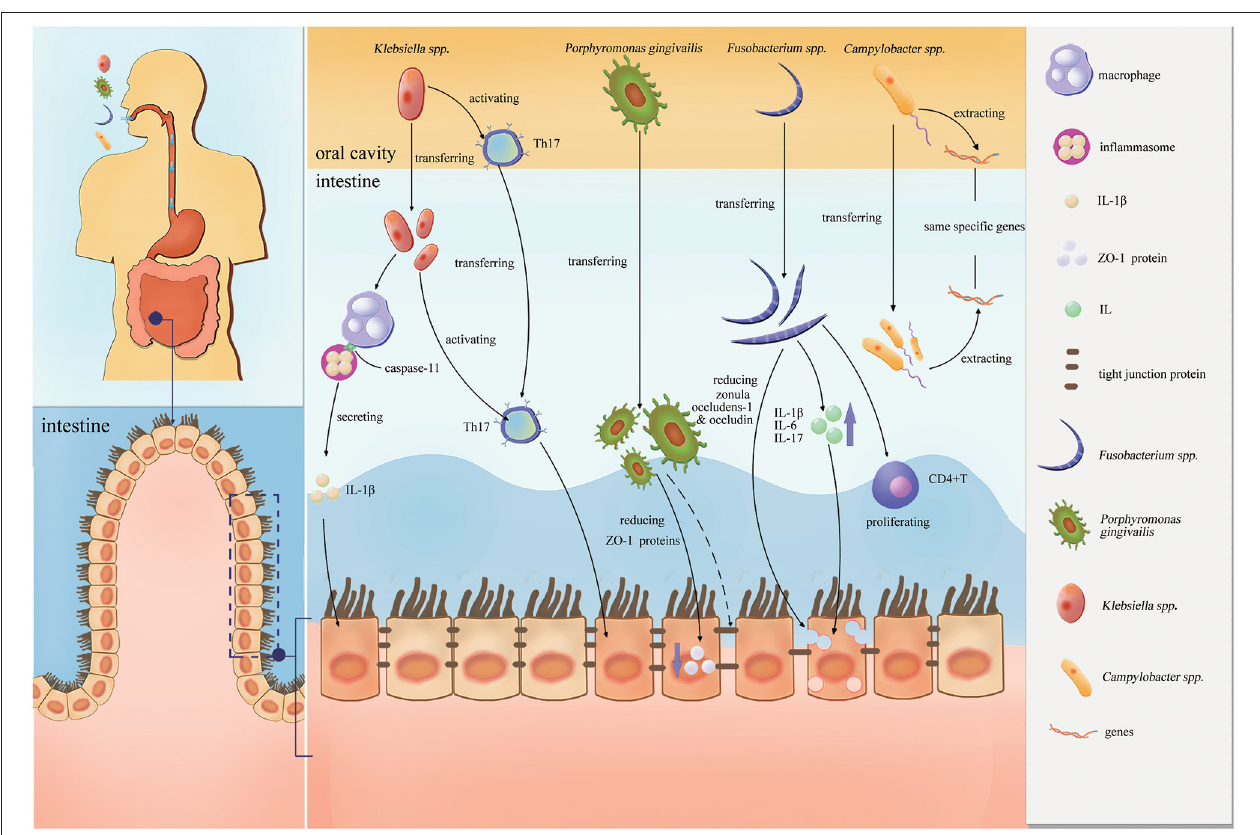
FIGURE 2 | Proinflammatory effects of the four pathobionts ( Porphyromonas gingivalis , Klebsiella spp., Fusobacterium spp., and Campylobacter spp.) in the intestines.